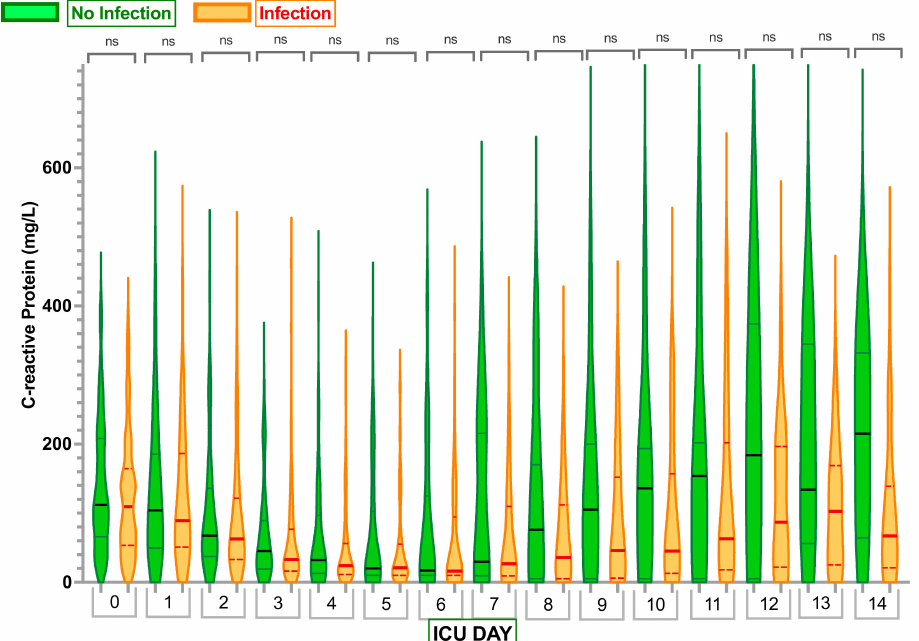
Figure 4. Comparison of C-reactive protein (CRP) levels in Infection Group and No Infection Group. Violin plots represent the distribution of data. Hard lines show medians, and dashed lines show interquartile ranges. The y-axis represents C-reactive protein (CRP) levels in mg/L. The x-axis represents Days in the Intensive Care Unit (ICU) with 0—C-reactive protein level Day 0. ns—no statistically significant difference from the Independent Mann–Whitney U test.